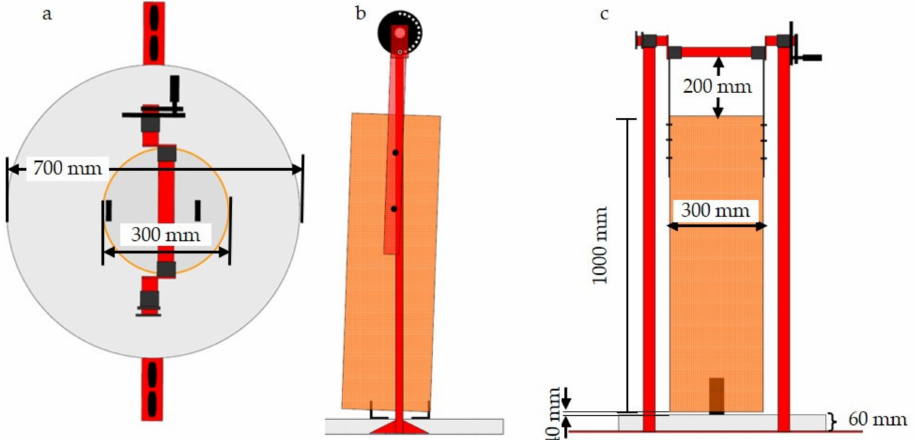
Figure 3. Dimensions (in mm) and layout of the rooting tower “Duesser Wuehlturm”. ( a ) tower viewed from above, in which the pipe is not centred in relation to the concrete base plate. The diameters of the concrete base plate and the pipe, which can be straw-filled, are depicted, ( b ) lateral perspective with the pipe not being centred. The swing radius of the pipe is restricted by rectangular brackets fixed on the base plate, ( c ) frontal perspective showing the heights of the base plate, the pipe and the distance between the pipe and steel